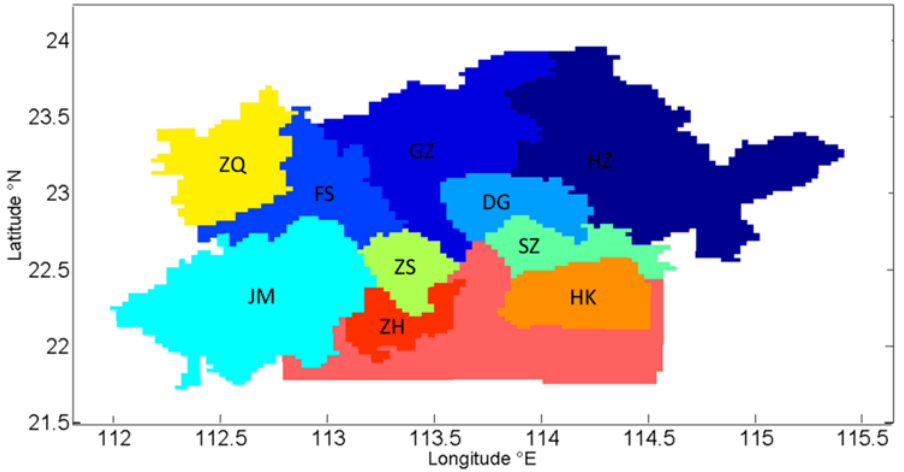
Figure 3. The source regions defined in the PRD region.